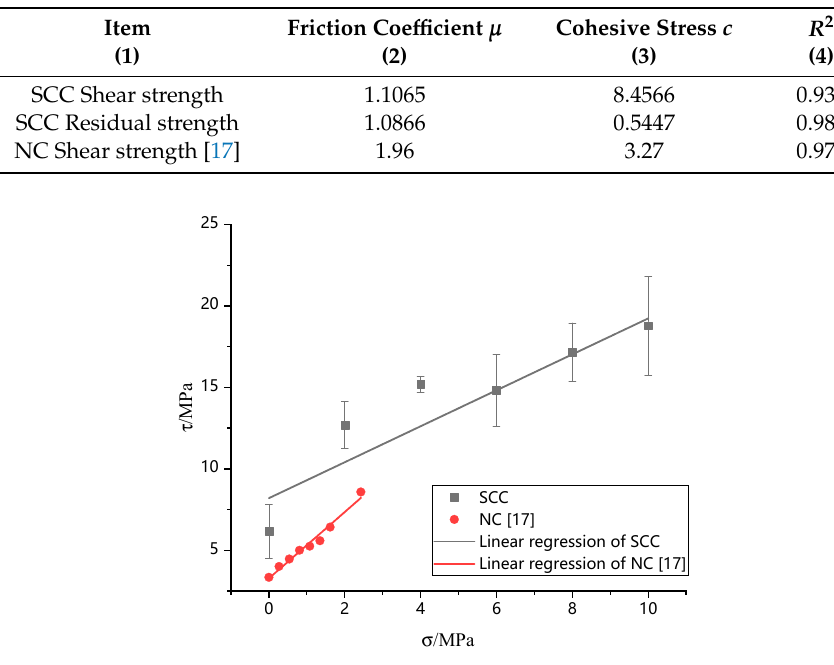
Table 5. Relationship between shear strength, residual strength, and axial force.